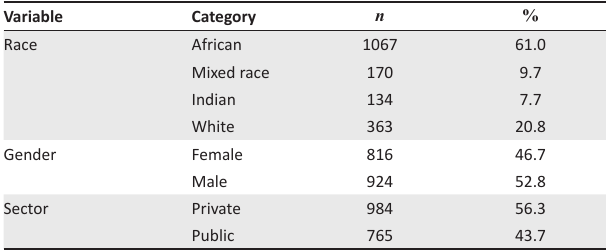
TABLE 1: Sample characteristics – Frequencies Of demographical variables, race, gender and the sector in which